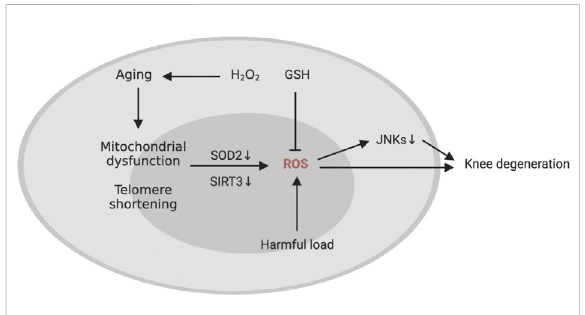
FIGURE 5 Chondrocyte senescence and oxidative stress. Hydrogen peroxide can cause the ageing of chondrocytes, such as telomere shorteningandmitochondrialdysfunction.Sirtuin3(SIRT3)protein is lost with ageing, which damages the SOD2 activity of cartilage, affects the regulation of mitochondrial redox in cartilage and stimulates ROS production. In addition, harmful mechanical loads can also stimulate an increase in ROS. Oxidative stress inactivates c-Jun N-terminal kinases (JNKs) and leads to cartilage degeneration. Reduced glutathione (GSH) can combat oxidative stress caused by